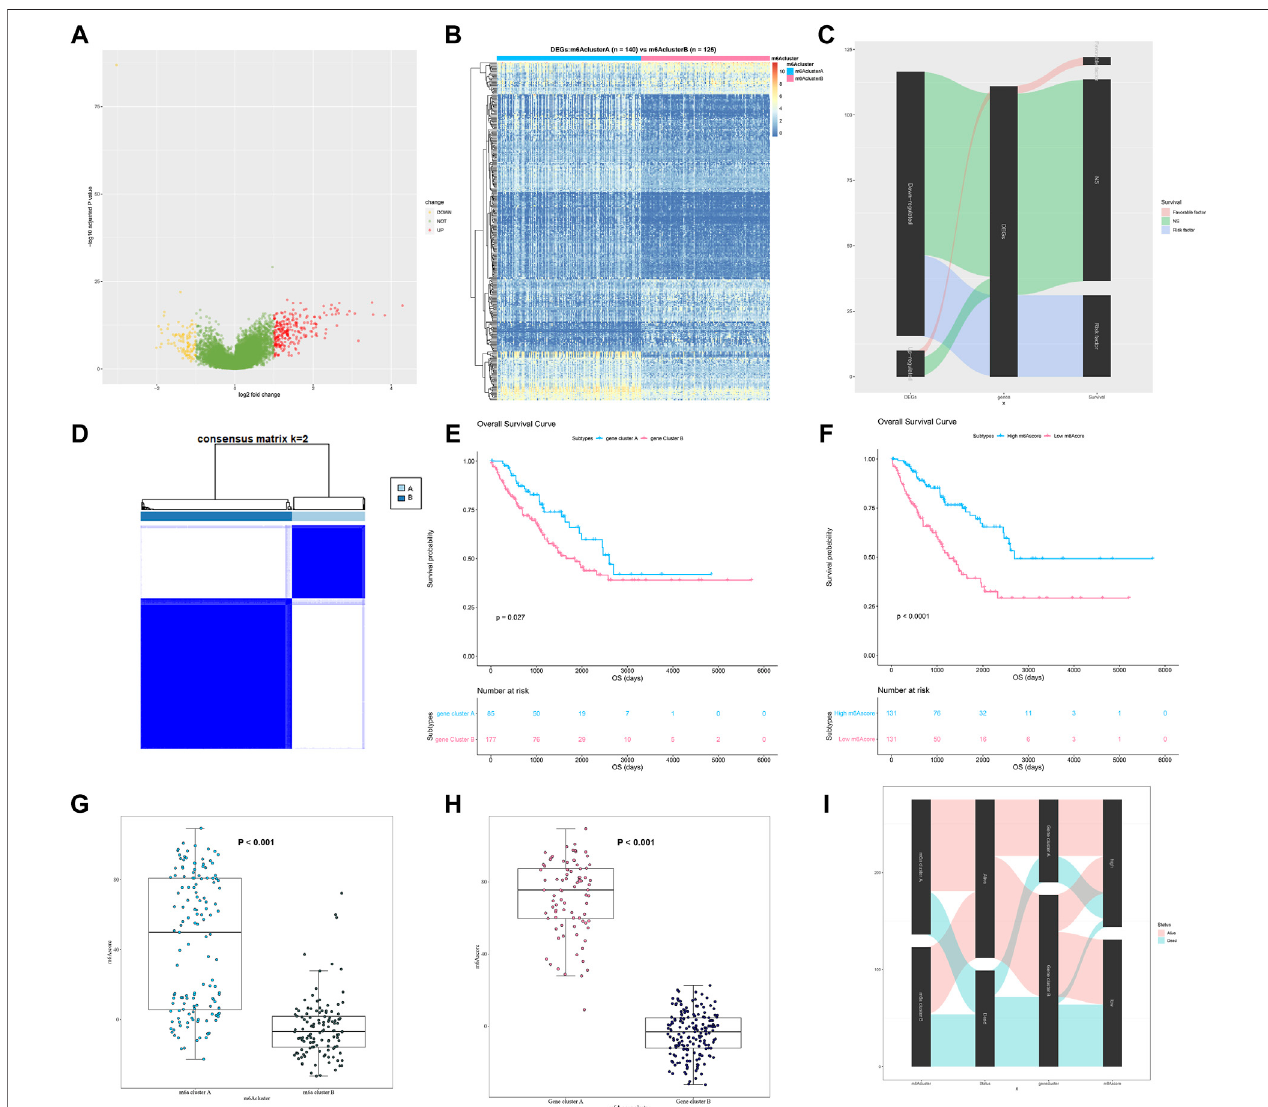
FIGURE7| Constructionofm6Ascore. (A) VolcanoplotofDEGsbetweenm6AclusterAandB; (B) theheatmapoftheexpressionofDEGsinm6AclusterAandB; (C) the relationship between DEGs and these prognostic genes visualized as a Sankey diagram; (D) the result of consensus clustering analysis in STS based on 328 DEGs; (E) survival plot of gene clusters A and B in TCGA-SARC ( p = 0.027); (F) survival plot of high and low m6A score in TCGA-SARC ( p < 0.0001); (G) comparison of m6A score among m6A clusters A and B; (H) comparison of m6Ascore among gene clusters A and B; and (I) the relationship between m6A clusters, gene cluster survival status, and m6A score visualized as a Sankey